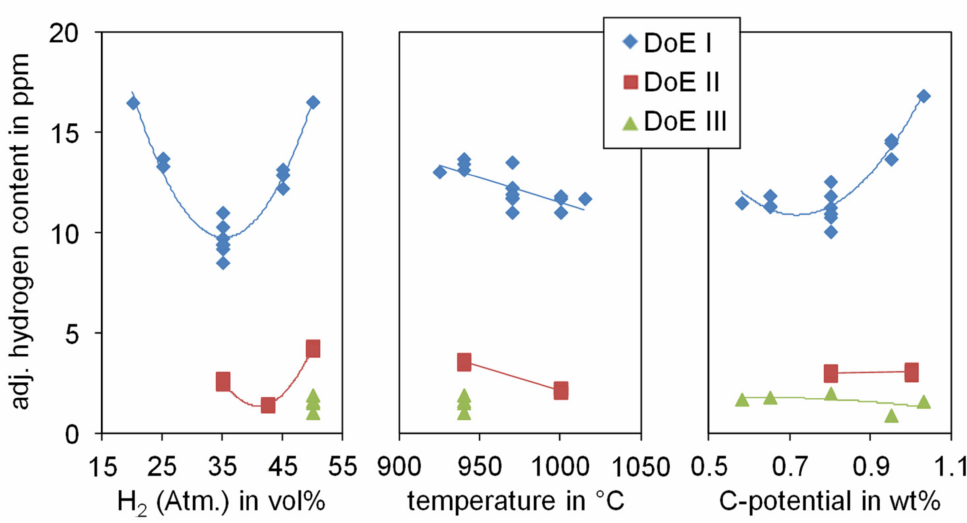
Figure 3. Hydrogen content in the iron foils as a function of the factors investigated: hydrogen content in the atmosphere, temperature and carbon